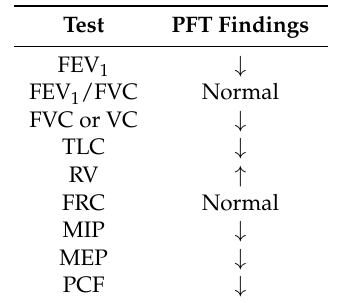
Table 1. Restrictive pattern of pulmonary function testing (PFT) in children characteristic of neuromuscular disease (NMD).